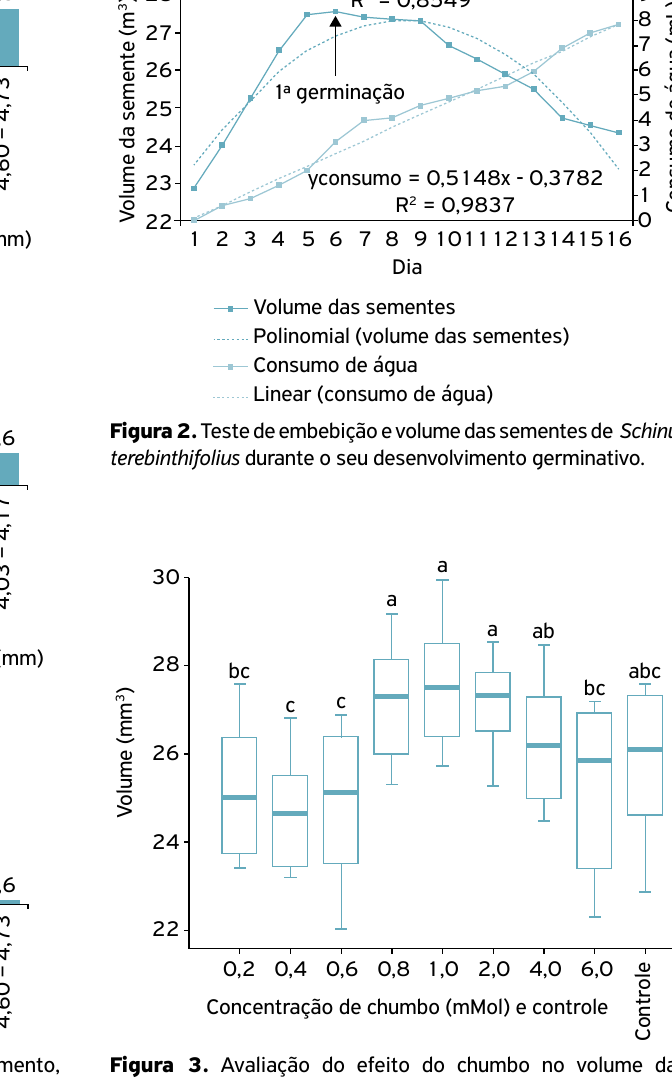
Figura 3. Avaliação do efeito do chumbo no volume das sementes de Schinus terebinthifolius durante o